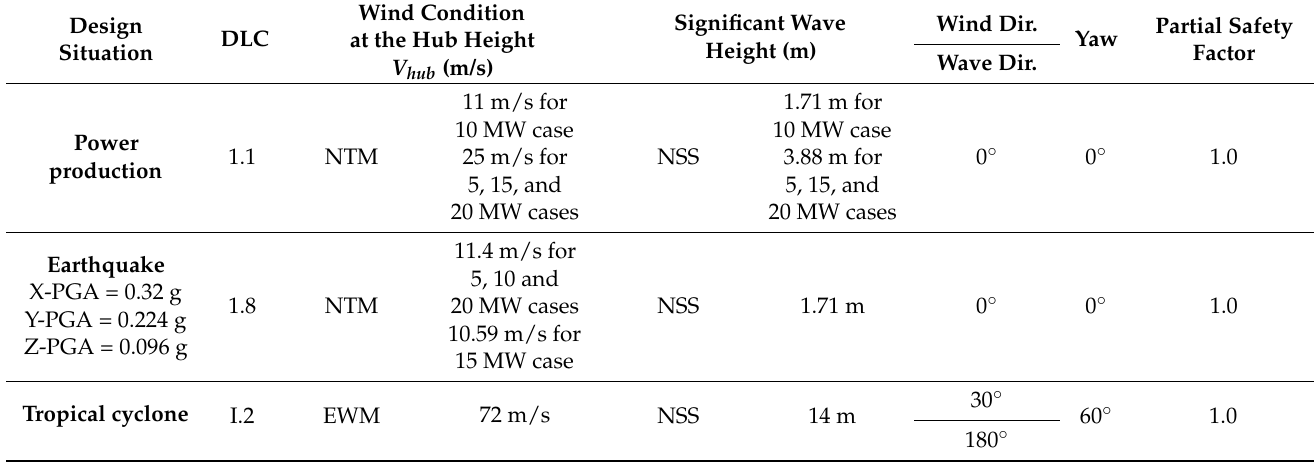
Table 2. The DLCs used in the settlement analysis of the OWT support structure.